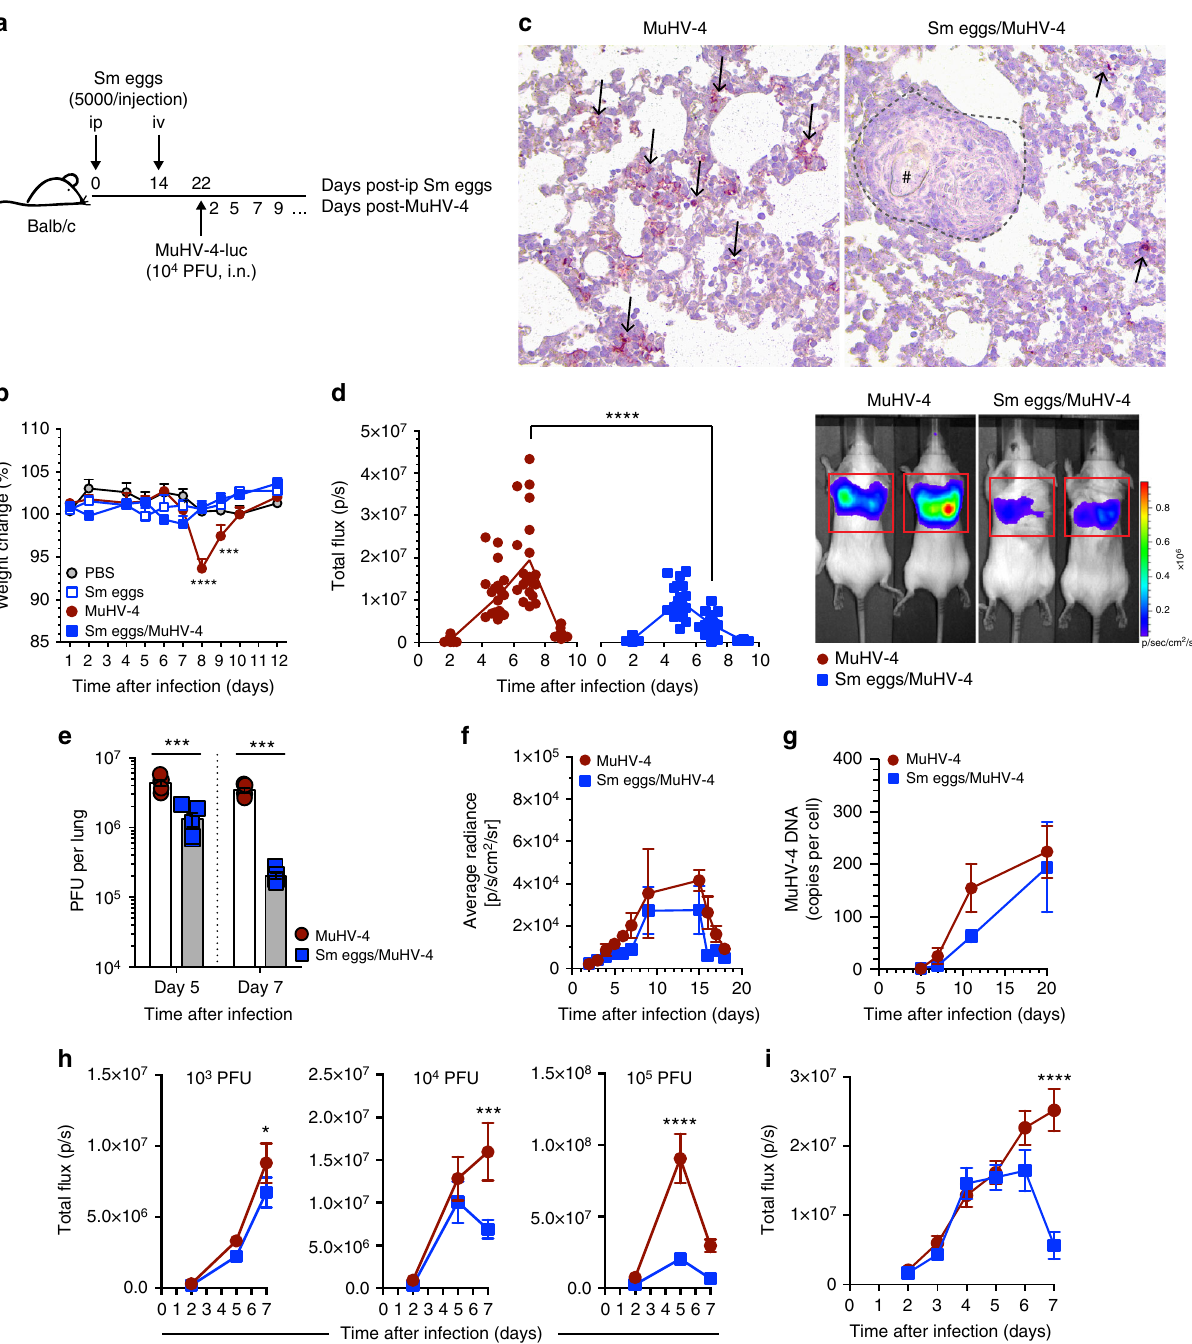
Fig. 3 S. mansoni egg immunization ameliorates the control of MuHV-4 lung infection. BALB/c mice were injected with S. mansoni (Sm) eggs i.p. and challenged i.v. (5,000 per injection) at day 14. At d22, MuHV-4-luc virus was administered i.n. ( b – g , i 10 4 PFU per mouse; h 10 3 , 10 4 , or 10 5 PFU per mouse in 30 μ L PBS). a Experimental design. b Body weight change as percentage of initial weight. c Immunostaining of MuHV-4-infected cells in representative lung sections of PBS- or Sm egg-treated mouse 7 days after MuHV-4-luc infection (day 7 pvi). Arrows indicate positive AEC signal. Dotted line shows boundaries of an egg-centered (#) granuloma. d Combined dorsal and ventral measurements by live imaging of thoracic light emission following D-luciferin injection. p s − 1 = photons per second. Representative photographs of bioluminescence signals of two mice per group are shown. e Lung titers at day 7 pvi as determined by plaque assay. f Live imaging of light emission of super fi cial cervical LN (scLN). g Splenic MuHV-4 DNA copy numbers at the indicated time points. h Live imaging of thoracic light emission following MuHV-4-luc infection with three different infectious doses. i Live imaging of thoracic light emission of lungs following MuHV-4-luc infection daily. Statistical signi fi cance calculated using two-way analysis of variance (ANOVA) and Sidak ’ s multiple-comparison test ( ** P < 0.01, *** P < 0.001, **** P < 0.0001). Data are representative of three independent experiments with fi ve to ten mice per group (mean ± s.e.m. in b, e – i